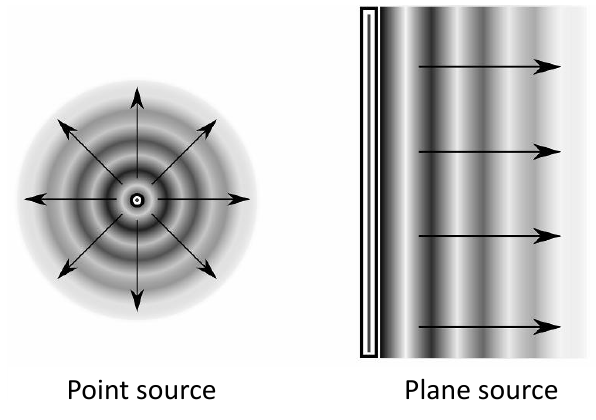
Figure 2. Radiation patterns of theoretical sound